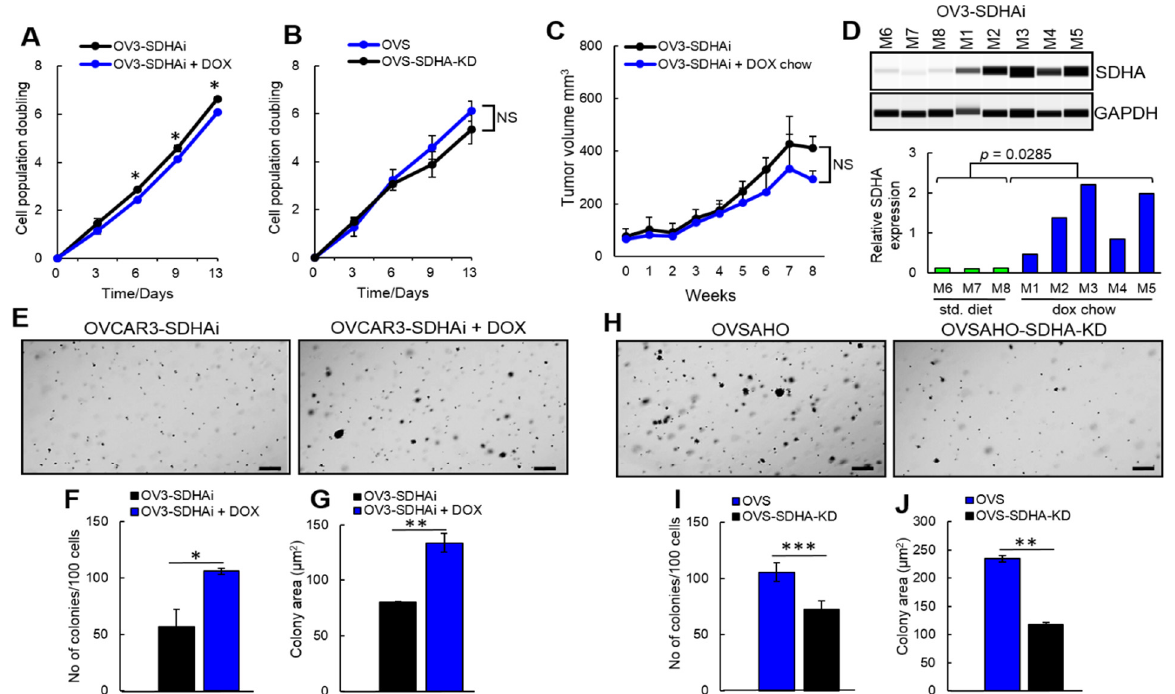
Figure 3. The effect of SDHA overexpression on cell proliferation and anchorage-independent growth. ( A ) The effect of inducible SDHA overexpression on OVCAR3 cell proliferation was assessed by 3T5 cell doubling assay. ( B ) The effect of SDHA KD on proliferation of OVSAHO cells. ( C ) In vivo OVCAR3-SDHAi subcutaneous tumor growth rate in NOD/scid mice. The SDHA over expression in tumors was induced by feeding mice with dox chow. Control mice were fed a control diet. ( D ) Quantification of the SDHA expression by WES in tumors resected from mice shown in ( C ). ( E ) Images represent anchorage-independent growth and colony formation of OVCAR3-SDHAi cells stimulated with dox. Number of colonies in cells overexpressing SDHA vs. controls was quantified in ( F ) and their size was assessed in ( G ). ( H ) Anchorage-independent growth of OVSAHO-SDHA-KD vs. control cells. Number of colonies in cells depleted from SDHA vs. controls was quantified in ( I ) and their size was assessed in ( J ). Data are expressed as mean ± SEM. Statistical significance of data was assessed by multiple t -test (3T5 assay) and unpaired t -test (WES and anchorage-independent growth assay); *** = p < 0.001 ** = p < 0.01 * = p < 0.05). The uncropped blots are shown in Figure S6.